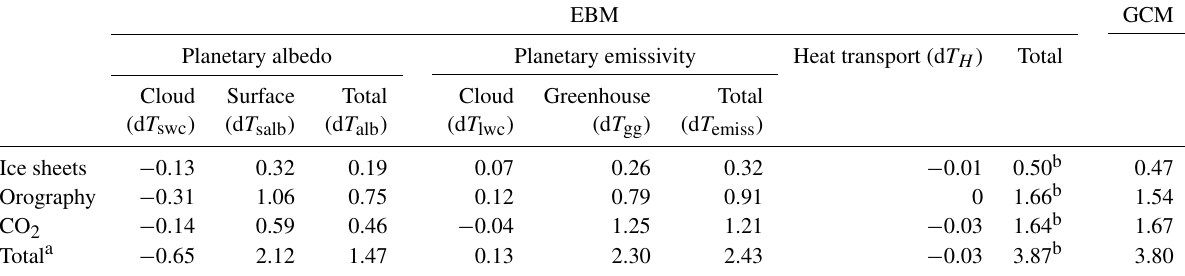
Table 5. Estimates of the contributions to the mid-Pliocene minus PI temperature difference from various mechanisms. All values are in units of ◦ C. The last row in the column indicating the total contribution of a mechanism is calculated from the decomposition shown in Fig. 9 and therefore may differ slightly from the sum of the contribution from ice sheets, orography, and CO 2 . EBM GCM Planetary albedo Planetary emissivity Total Cloud Surface Total